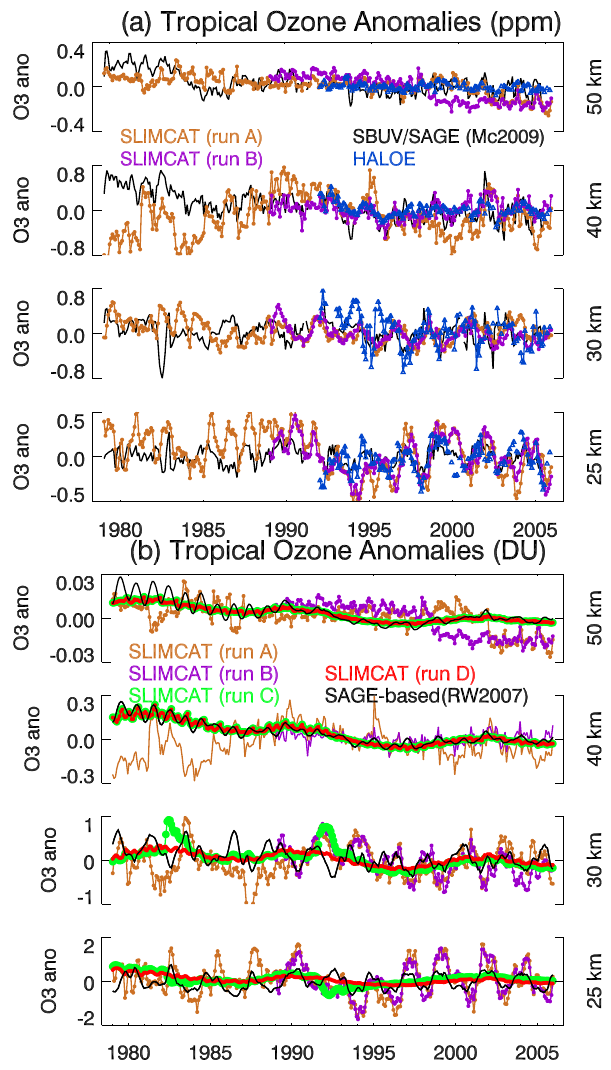
Fig. 2. Comparison of tropical (25 ◦ S–25 ◦ N) ozone anoma- lies from SBUV/SAGE (from McLinden et al., 2009, black line), SAGE-based (from Randel and Wu, 2007, black line), and HALOE (blue line) with model runs A E40 (orange line), B EI (violet line), C FIX (green line),and D AFIX (red line). Anomalies are shown for 50km (top), 40km (second from top), 30km (third from top), and 25km (bottom). Ozone anomalies from HALOE were calcu- lated by combining both sunrise and sunset measurements. Anoma- lies are shown in ppmv (a) andDU/km (b)